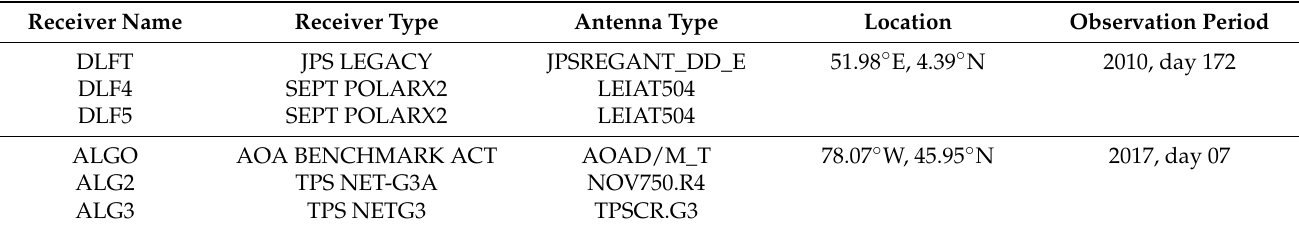
Table 1. A general overview of two groups of co-located